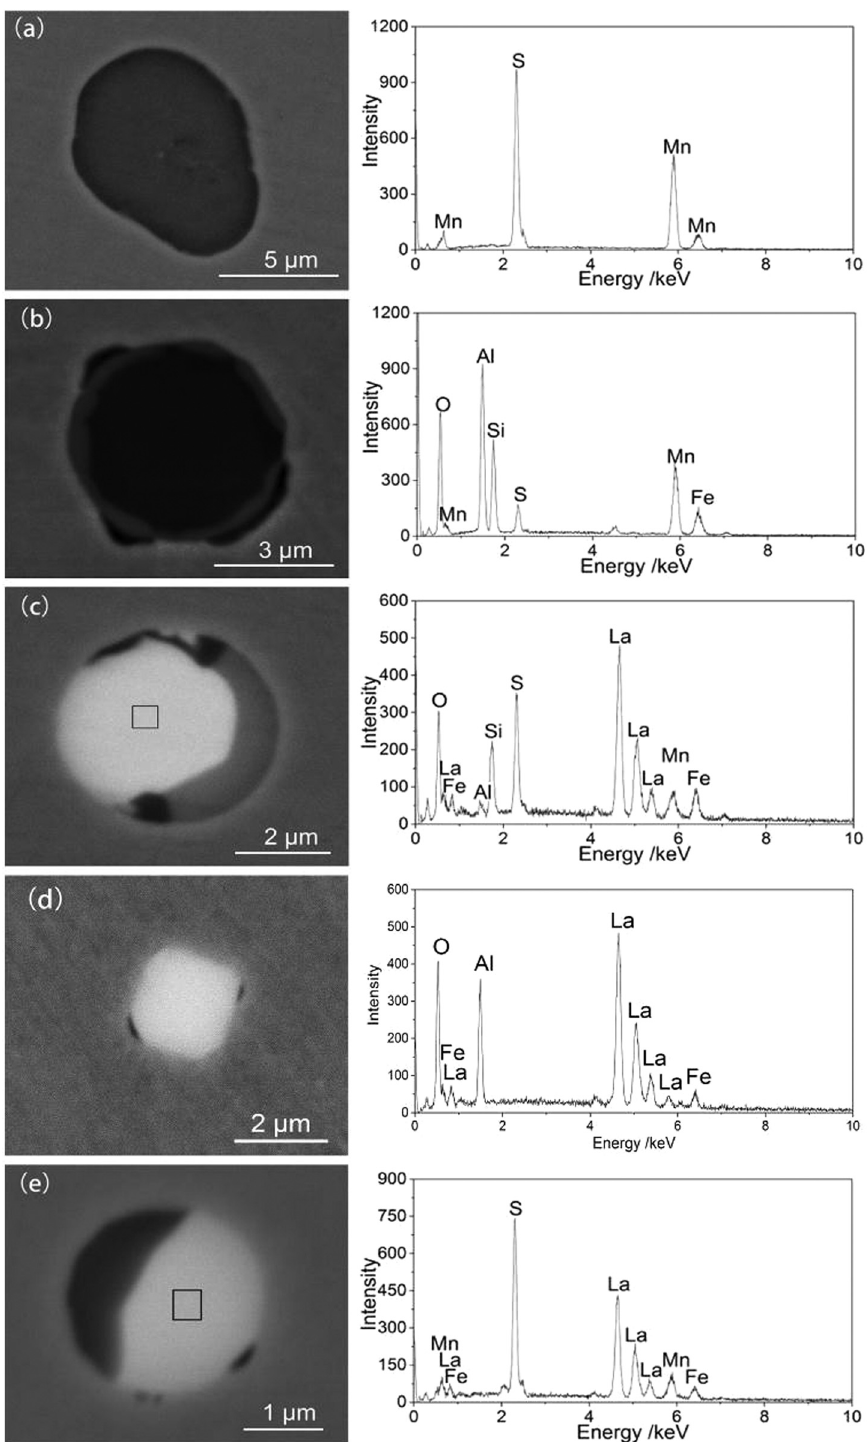
Figure 6: The composition and morphology of inclusions in three as - cast steels. ( a and b ) Steel no. 1, ( c ) steel no. 2, and ( d ) and ( e ) steel no.